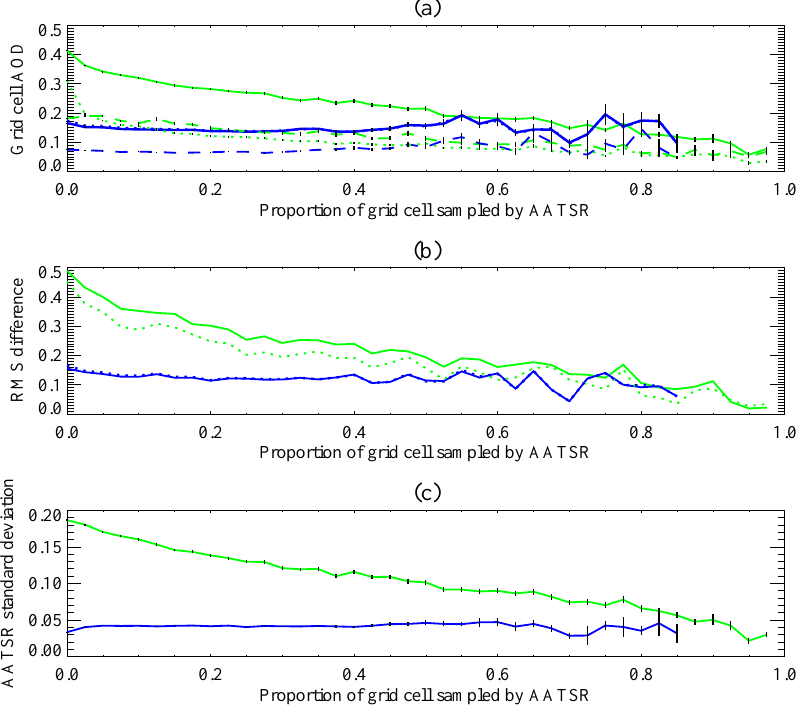
Fig. 6. Change in model and satellite AOD binned as a function of p , constructed from daily AOD fields containing GlobAerosol data. In all figures, blue indicates grid cells over ocean and green over land. Error bars are the standard errors on values (with a bin size of 0.025 in p ). Shown in (a) is the mean AOD for each bin calculated from AATSR grid-cell means (solid lines), AATSR grid-cell medians (dotted lines), and the GEOS-Chem model (dashed lines). Panel (b) is the RMS difference in AOD between GEOS-Chem and AATSR grid-cell means (solid lines), and GEOS-Chem and AATSR grid-cell medians (dotted lines). Panel (c) shows the mean AATSR grid-cell standard deviation of AOD.